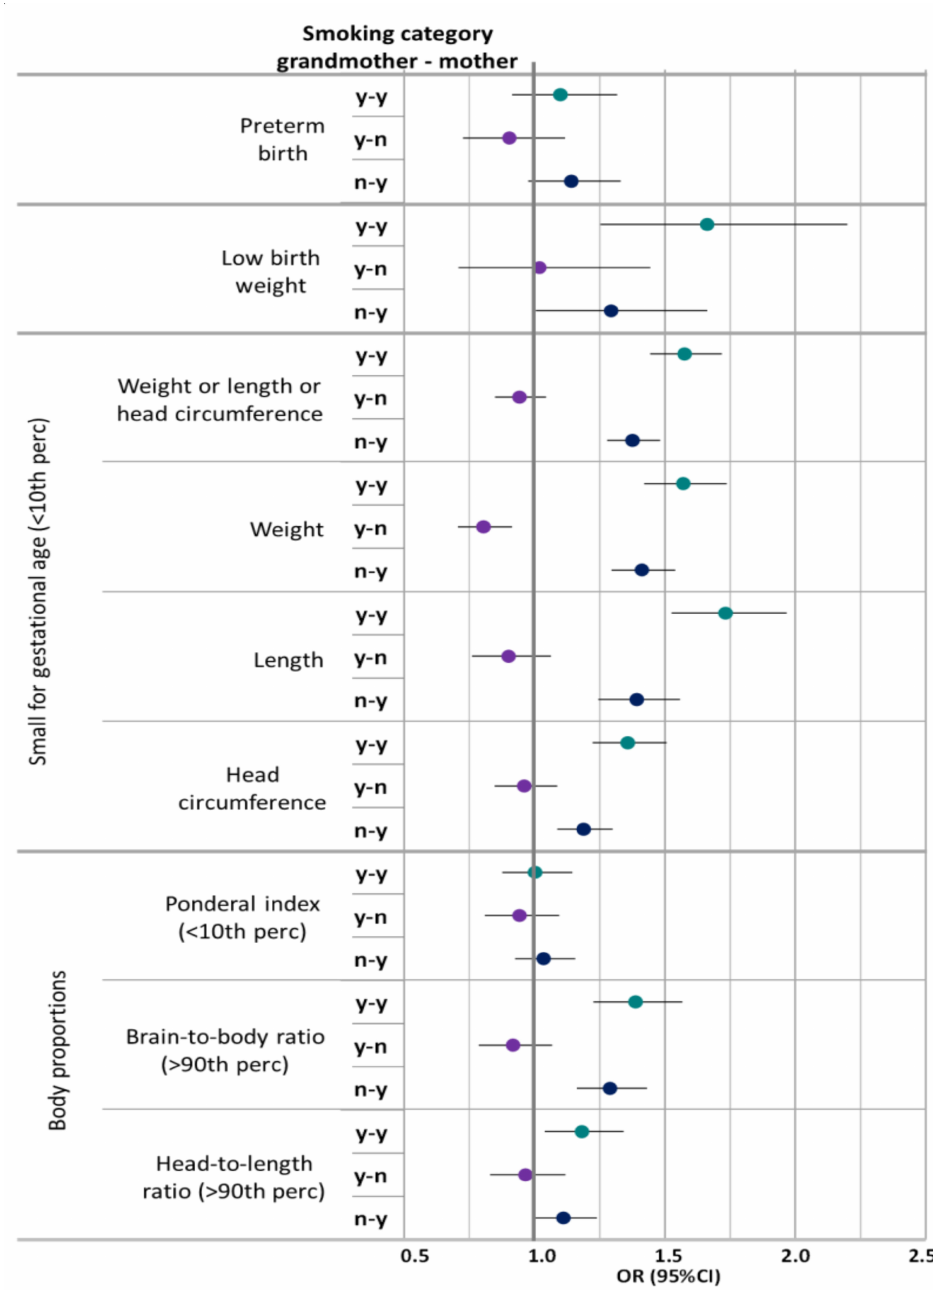
Figure 1. Adjusted ORs for the combined effect of grandmaternal and maternal smoking on birth outcomes in reference to grandmother and mother not smoking. Adjusted for maternal age, sex, maternal parity, maternal socioeconomic status, for grandmaternal age, grandmaternal parity, and grandmaternal socioeconomic status, maternal low birth weight and maternal preterm birth, ma- ternal co-morbidities during pregnancy; low birth weight in addition for gestational age. Smoking categories: y-y: Any smoking grandmother and mother; y-n: Any smoking grandmother, no smoking mother: n-y: No smoking grandmother, any smoking mother; Reference: no smoking grandmother or